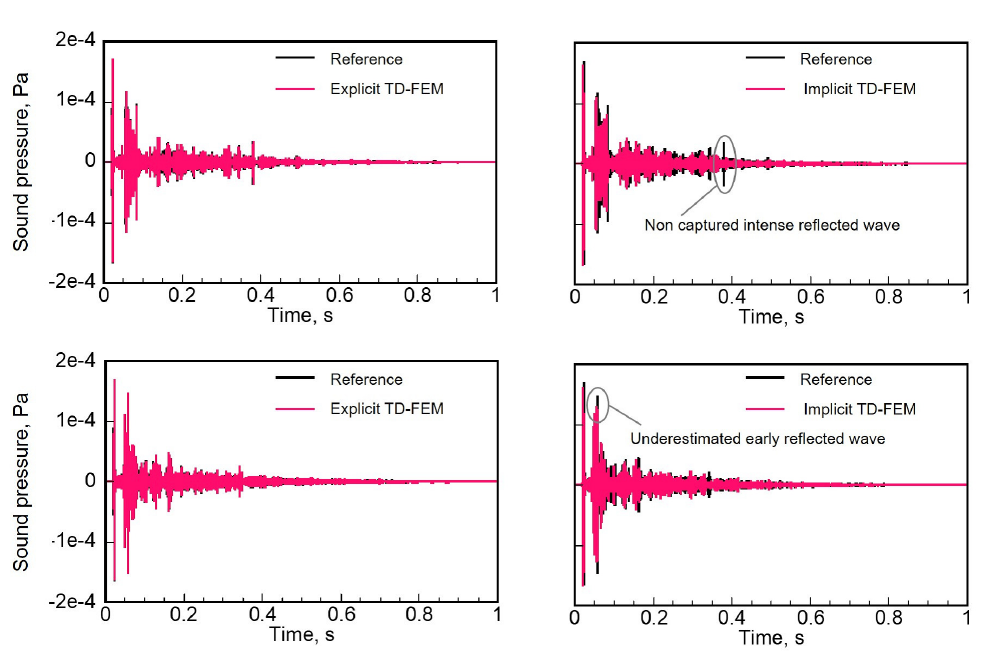
Figure 14. Band-limited impulse responses at R1 among the reference solution, the proposed explicit TD-FEM, and the standard implicit TD-FEM for Cond. 1 (upper row) and Cond. 2 (lower row).